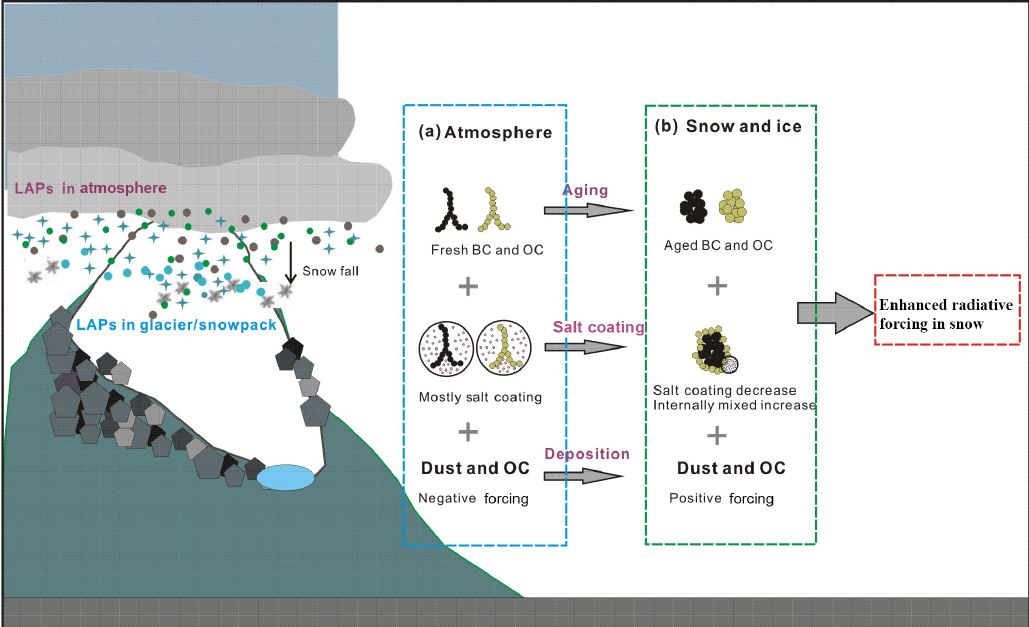
Figure 12. Schematic diagram linking aging and salt-coating change and comparing its influence to the radiative forcing between the atmo- sphere and snowpack of a remote glacier basin, thereby causing markedly enhanced heat absorption.